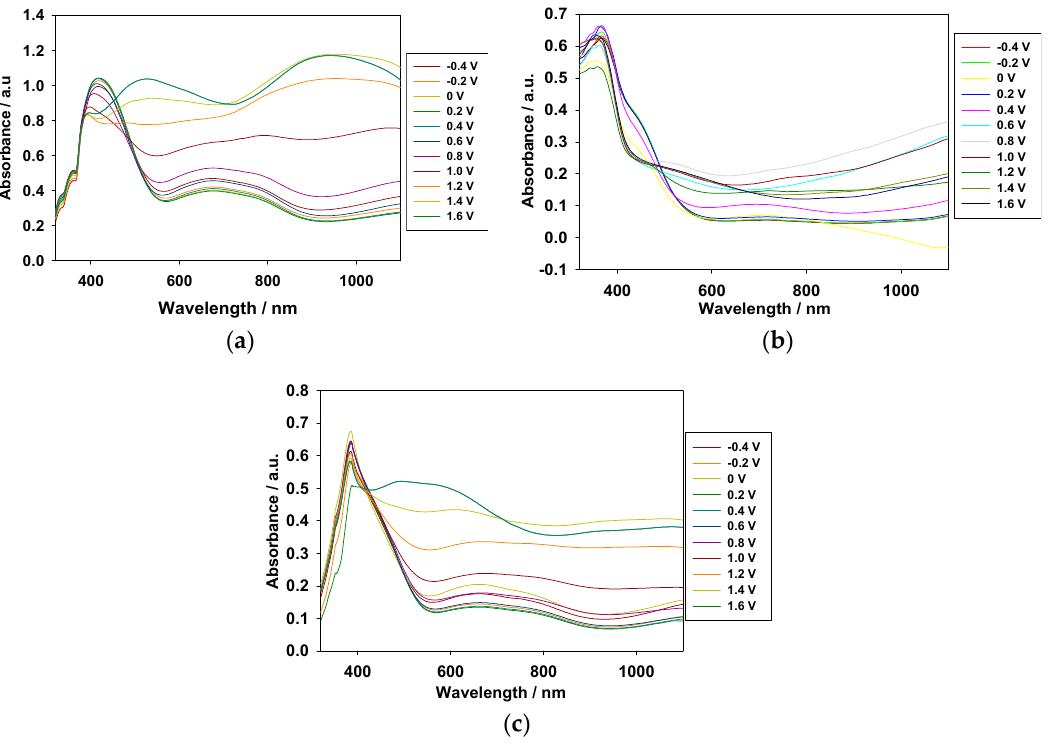
Figure 5. UV-Vis spectra of ( a ) P(MPS- co -TTPA); ( b ) P(MPO- co -TTPA); and ( c ) P(ANIL- co -TTPA) films at various potentials.